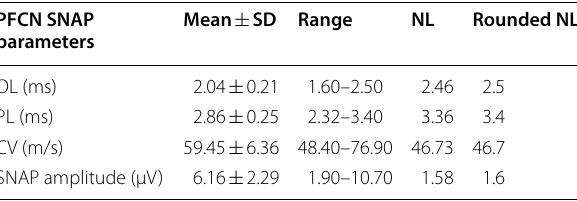
PFCN, posterior femoral cutaneous nerve; SNAP, sensory nerve action potential; OL, onset latency; PL, peak latency; CV, conduction velocity; SD, standard deviation; NL, upper (latency) or lower (conduction velocity and amplitude) limit of